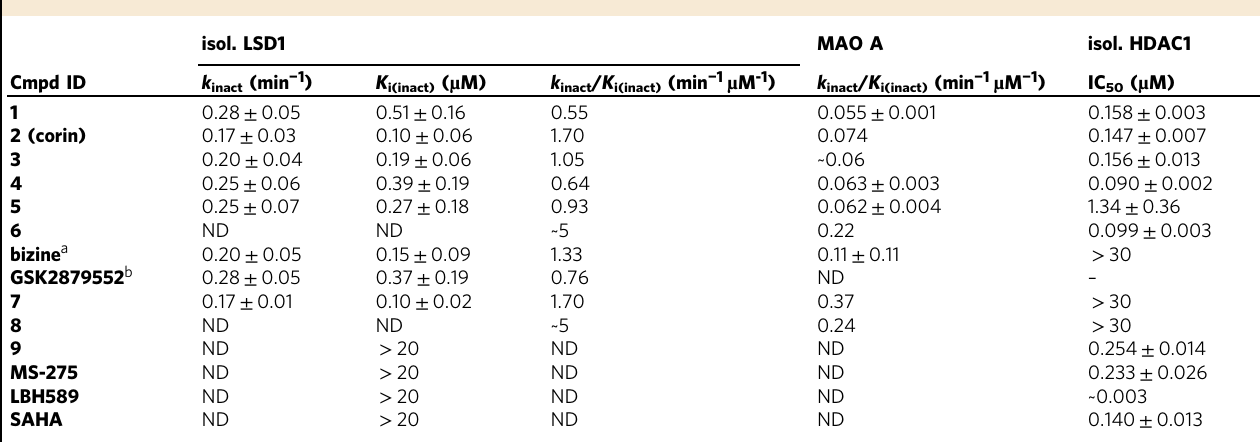
Table 1 Summary of inhibitor properties toward isolated LSD1, isolated HDAC1, and MAO